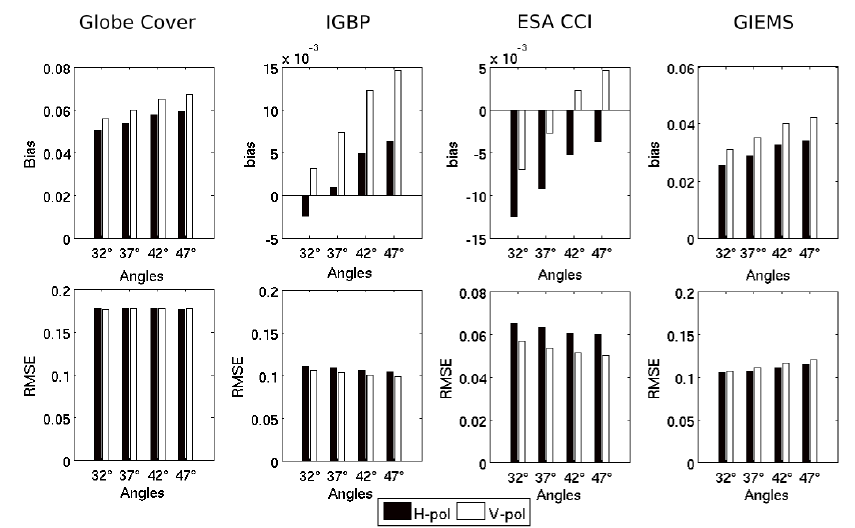
Figure 9. Bias (reference static maps, SWAF) and RMSE values computed between each reference maps (GlobeCover, IGBP, ESA CCI, GIEMS) and SWAF for the eight